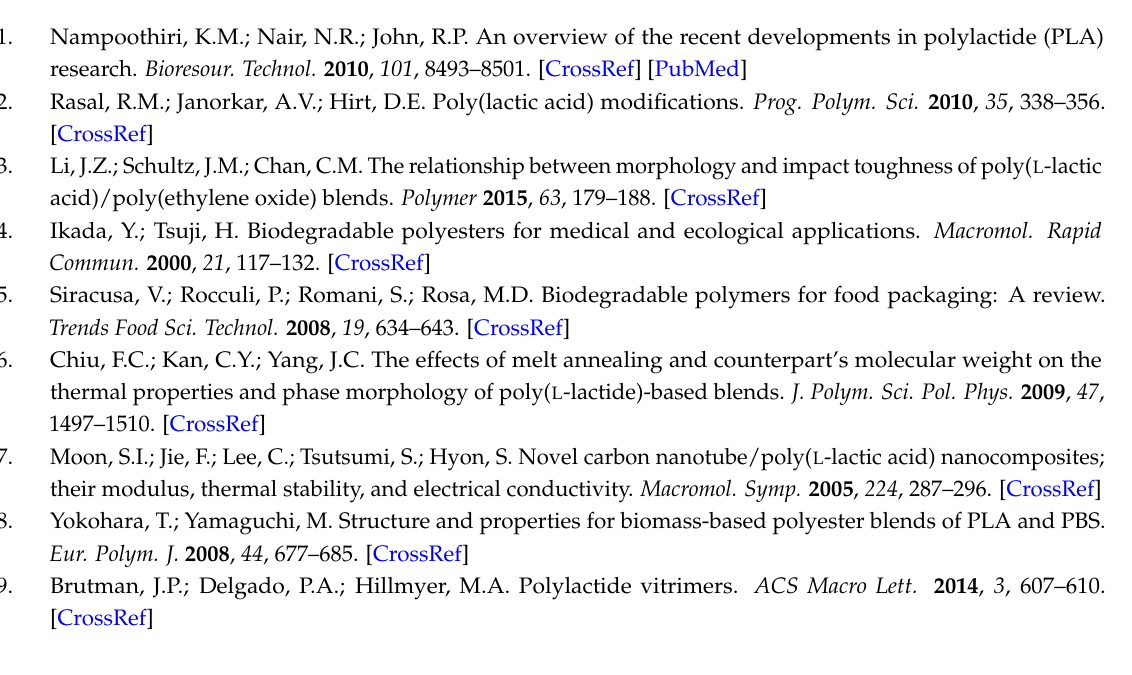
Figure S2: DSC curves of the neat PLLA, Figure S3: DSC heating curves of PLLA, PDLA-PEG 4k -PDLA100, and PDLA-PEG 4k -PDLA400 blocks after quenching from 240 ◦ C, Figure S4: Isothermal crystallization curves of the blends with different PEG blocks at 160 ◦ C: (a) PLLA/PDLA-PEG X -PDLA100; (b) PLLA/PDLA-PEG X -PDLA400, Figure S5: Variation of X t with crystallization time t of PLLA/PDLA-PEG X -b-PDLA100 and PLLA/PDLA-PEG X - PDLA400 at different crystallization temperatures, Figure S6: POM images of the blends with different PEG blocks isothermally crystallized at 170 ◦ C: (a) PLLA/PDLA-PEG X -PDLA100; (b) PLLA/PDLA-PEG X -PDLA400, Figure S7: Isothermal crystallization curves of the blends with different PDLA blocks at different temperatures, Figure S8: Variation of X t with crystallization time t of the blends with different PDLA blocks at different crystallization temperatures, Figure S9: The plots of log[–ln(1– X t )] versus log t at different crystallization temperatures, Figure S10; POM images of the blends with different PDLA blocks isothermally crystallized at different temperatures, Table S1: Avrami kinetic parameters for the isothermal crystallization of PLLA/PDLA-PEG 4k -PDLA with different PDLA